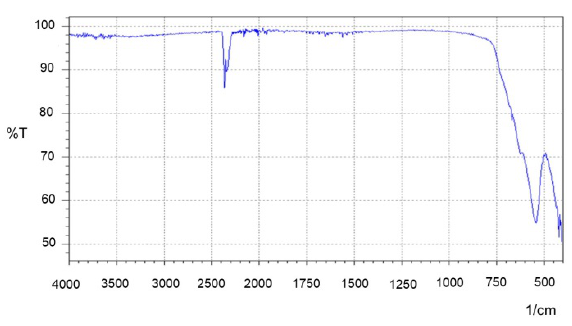
Figure 3. FTIR spectrum of maghemite